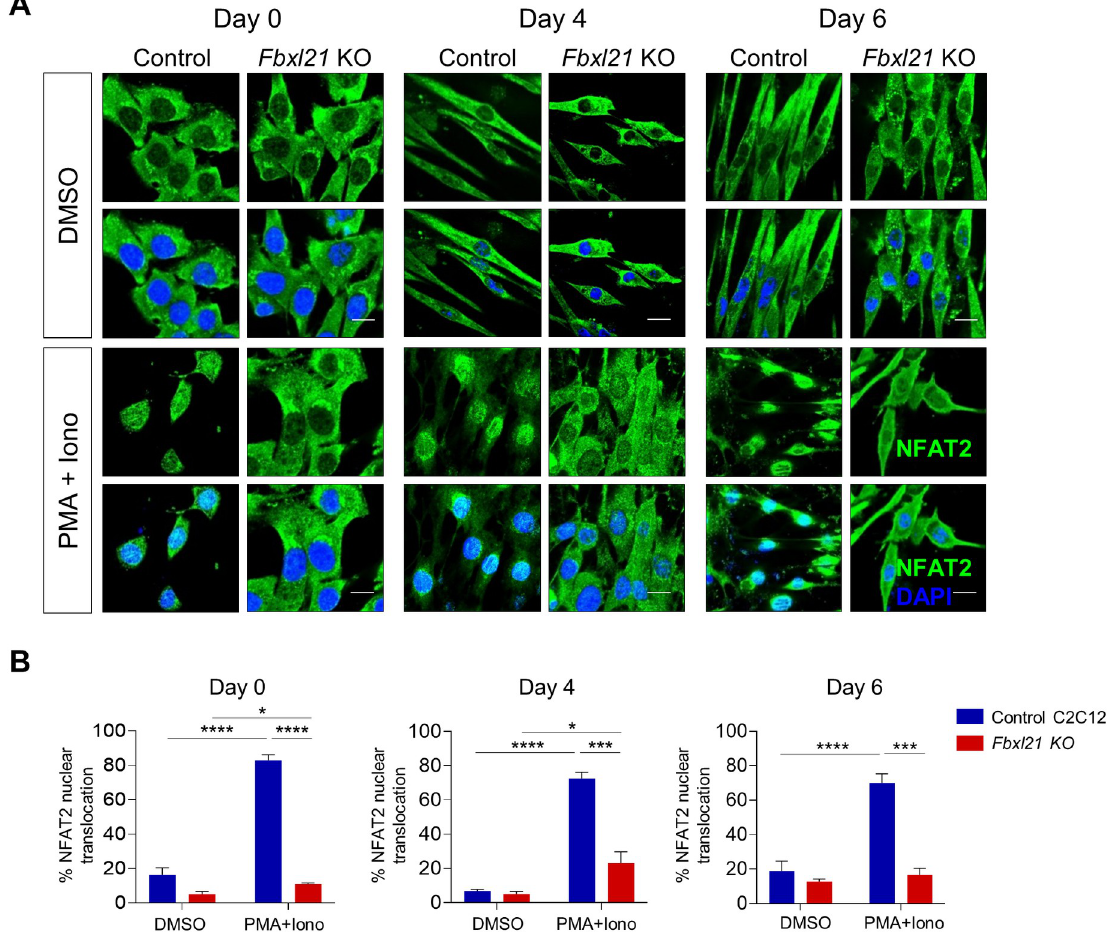
Fig 4. Fbxl21 deletion impairs NFAT2 nuclear translocation in C2C12 cells. (A) Immunofluorescence staining of NFAT2 in control and Fbxl21 KO C2C12 cells. Cells were differentiated for indicated days (Day 0, 4, and 6) with 2% horse serum, and treated with DMSO or the calcineurin activator PMA (20 ng/ml) and ionomycin (0.25 μ M) (PMA + Iono) for 1 h. Control and Fbxl21 KO C2C12 cells were immunostained with NFAT2 antibody, and imaged by confocal microscopy. Upon the treatment of PMA and ionomycin (PMA + Iono), NFAT2 nuclear translocation was significantly increased in control C2C12 cells at all differentiation stages (Day 0, 4, and 6), but was inhibited in Fbxl21 KO C2C12 cells. (B) Quantification of NFAT2 nuclear translocation in control and Fbxl21 KO C2C12 cells. Data are presented as mean ± SEM (n = 3), � p < 0.05, ��� p < 0.001, and ���� p < 0.0001; t-test. Scale bar, 15 μ m.